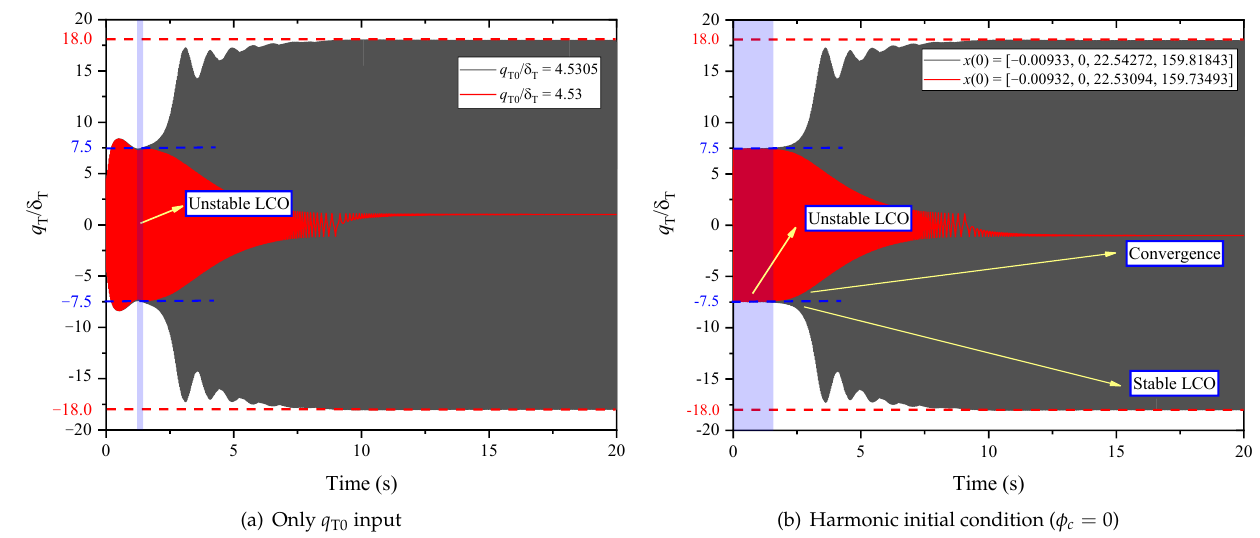
Figure 7. Observation of the unstable LCO and the application of the harmonic initial condition in time-domain integration ( K B = 5.0 × 10 3 N · m/rad, K T = 2.0 × 10 3 N · m/rad, Q = 48.0